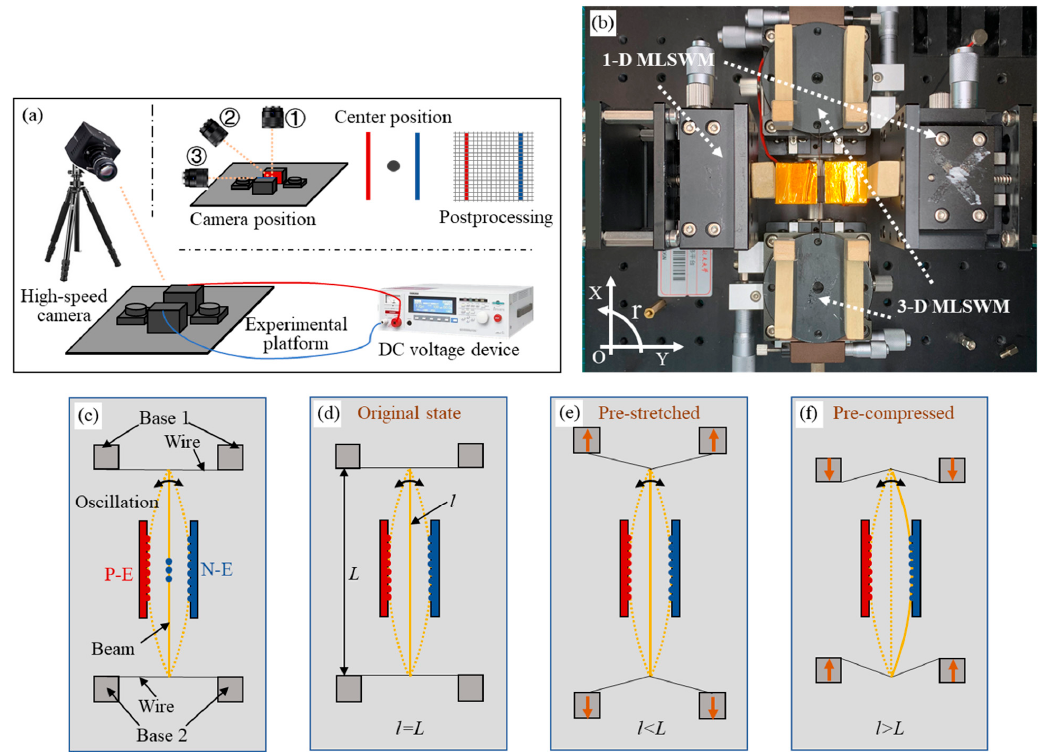
Figure 3. Experiment platform for the resonator under different pre-constraint conditions: ( a ) Schematics of the test system. ( b ) The photo (top view) of the experimental platform. ( c ) Installation position of the electrodes, beam, and constraint bases. ( d ) Schematics showing that when l = L , the microbeam is under the original constraint. ( e ) When l < L , the microbeam is under pre-stretched constraint. ( f ) When l > L , the microbeam is under pre-compressed constraint. Where the solid line means the stable position, the dotted line represents the oscillation process.